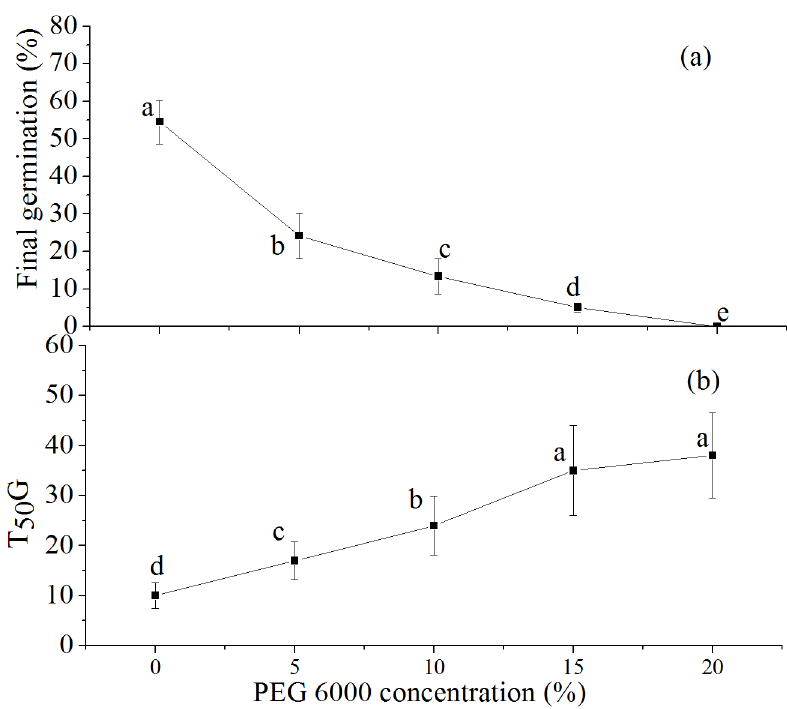
Fig 2. Effects of simulateddroughtstress on final seed germination rate (a) and time to 50% germination (b) of Nyssa yunnanensis seeds.